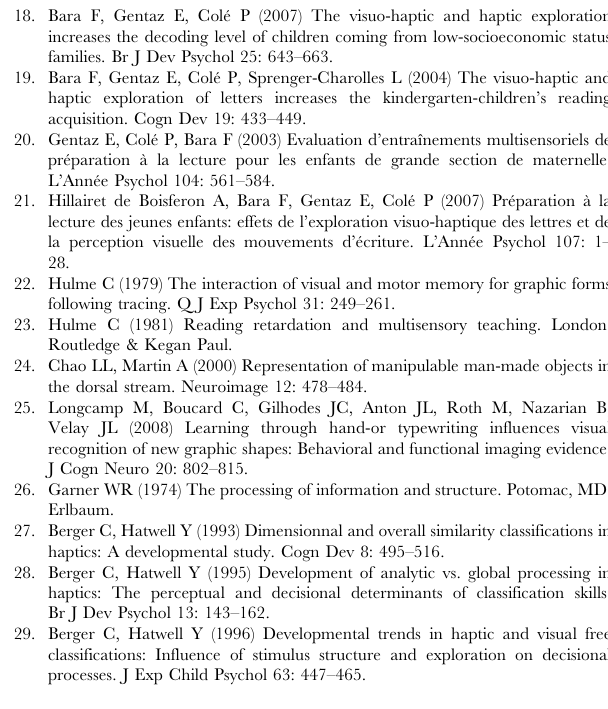
Figure S1 Mean number and standard error of visual and auditory stimuli correctly recognized (maximum 15) as function of